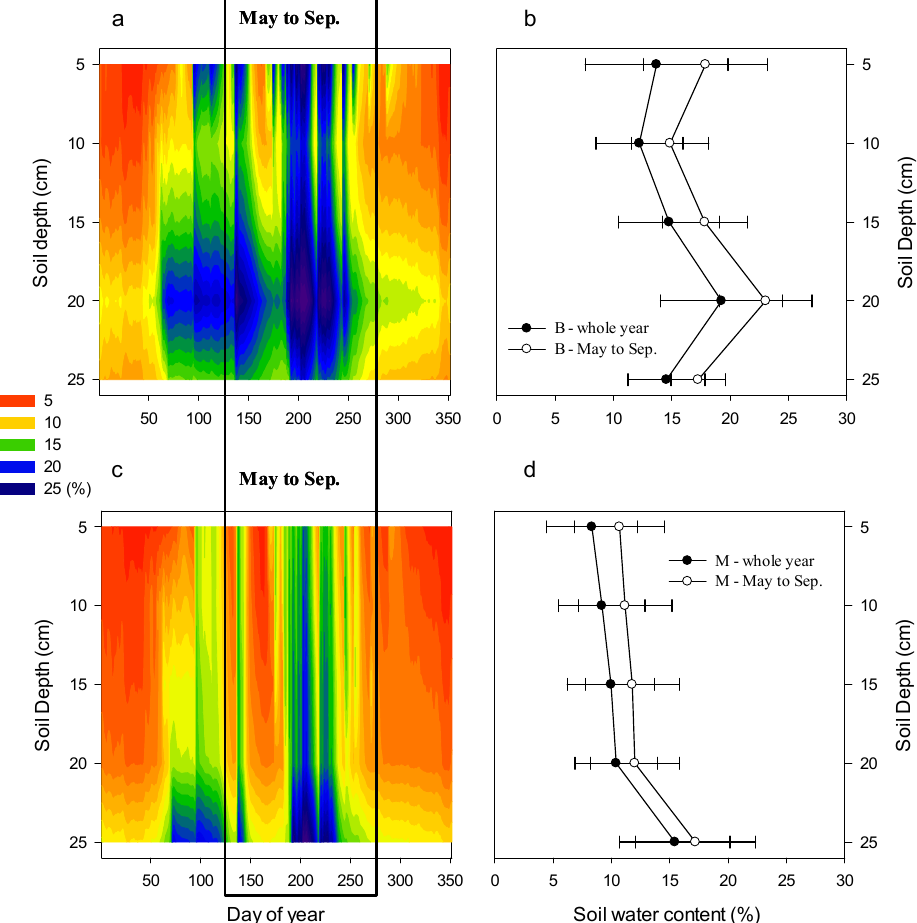
Figure 4. Temporal-spatial variation of soil volumetric water content. Soil volumetric water content (SWC) in the Bromus inermis grassland ( a , b ) and the Medicago sativa grassland ( c , d ). Different colors indicate different soil volumetric water content ( a , c ). Mean SWC at each soil depth for the whole year and for the period from May to September are depicted on the right-side ( b , d ). Bars denote standard deviation.